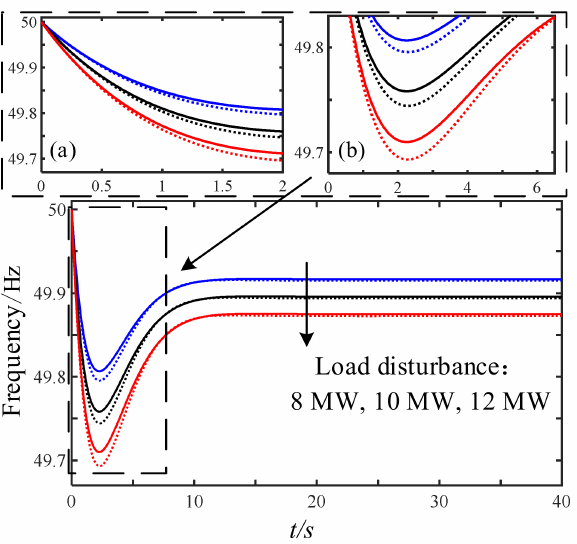
Figure 9. System frequency characteristic with/without asynchronous motor when the load disturbance is increasing. ( a ) The maximum rate of change of frequency; ( b ) The maximum frequency